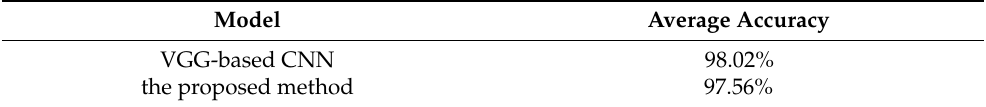
Table 1. The comparison of the proposed and VGG-based CNN method.